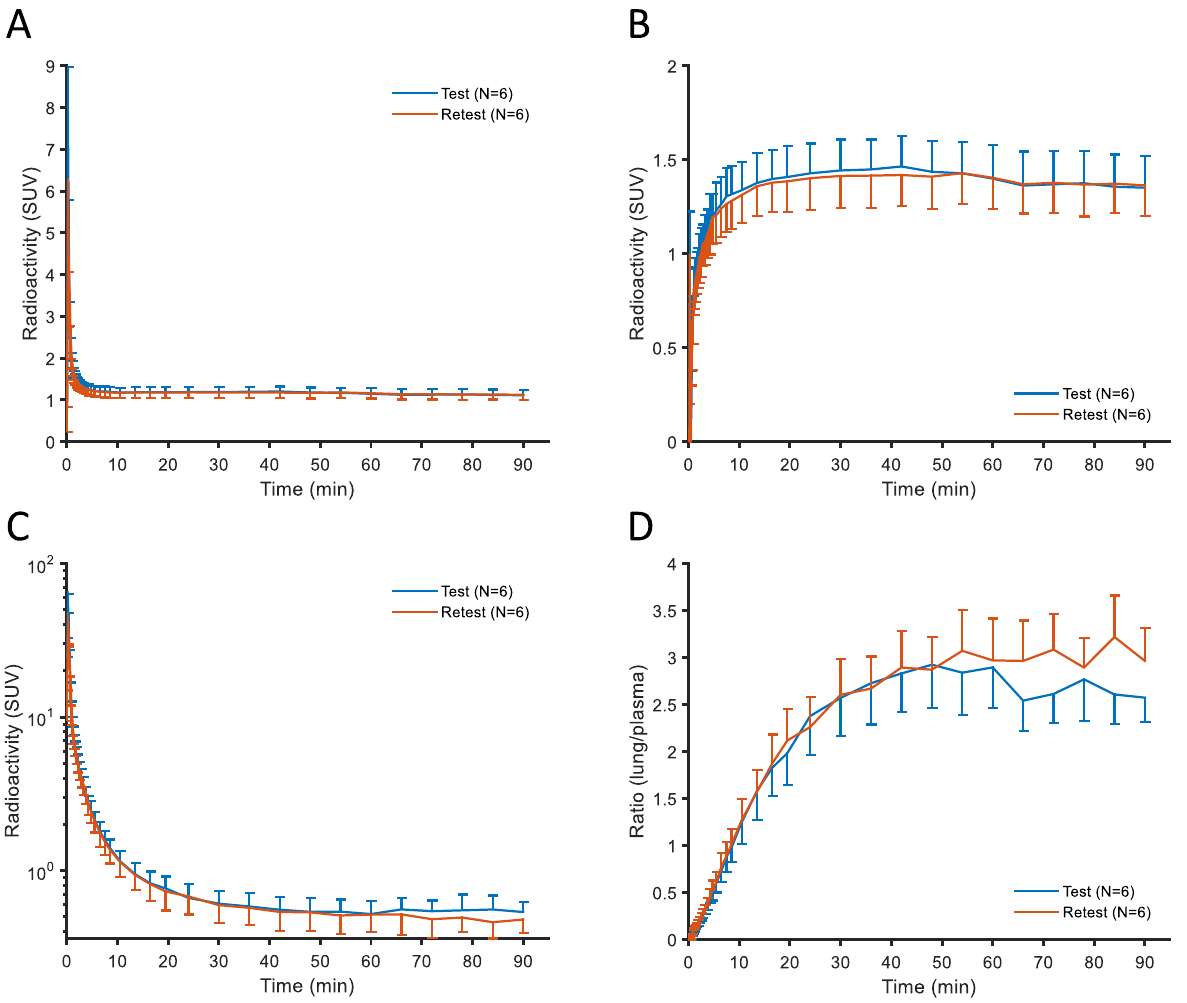
Fig. 2 a Time-radioactivity curves (TACs, mean ± SD) in standardized uptake value units (SUV) for the lung after i.v. injection of [ 11 C]VC-002. b TACs in lung, corrected for radioactivity in pulmonary blood volume. c TACs in plasma. d Lung-to-plasma ratio of